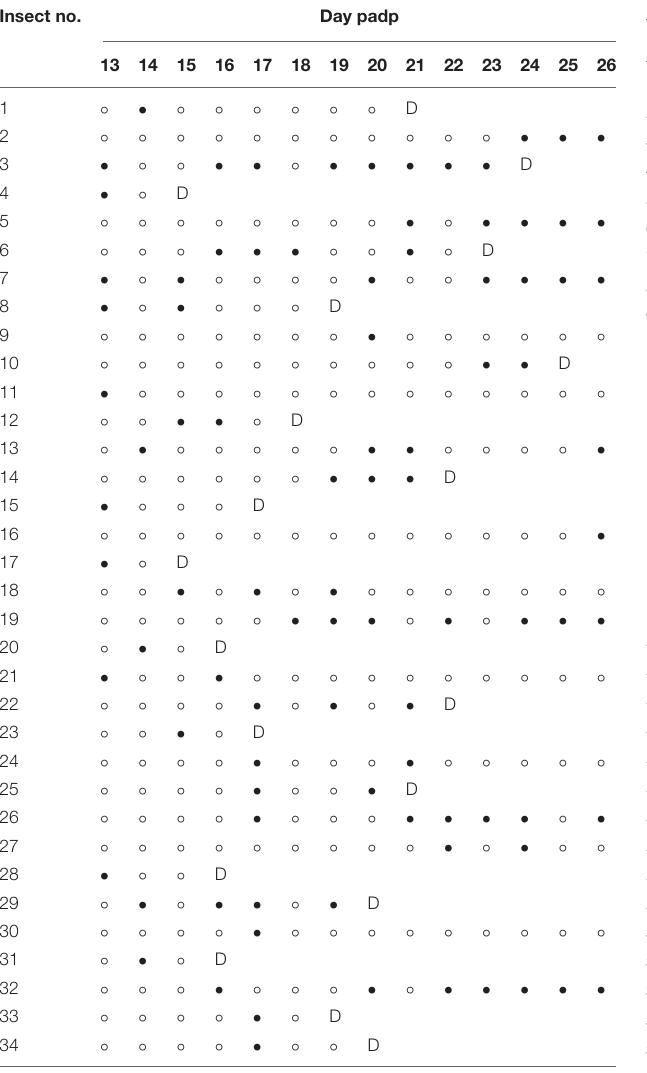
TABLE 1 | Pattern of daily transmission of RDV by individual leafhoppers. Insect no.